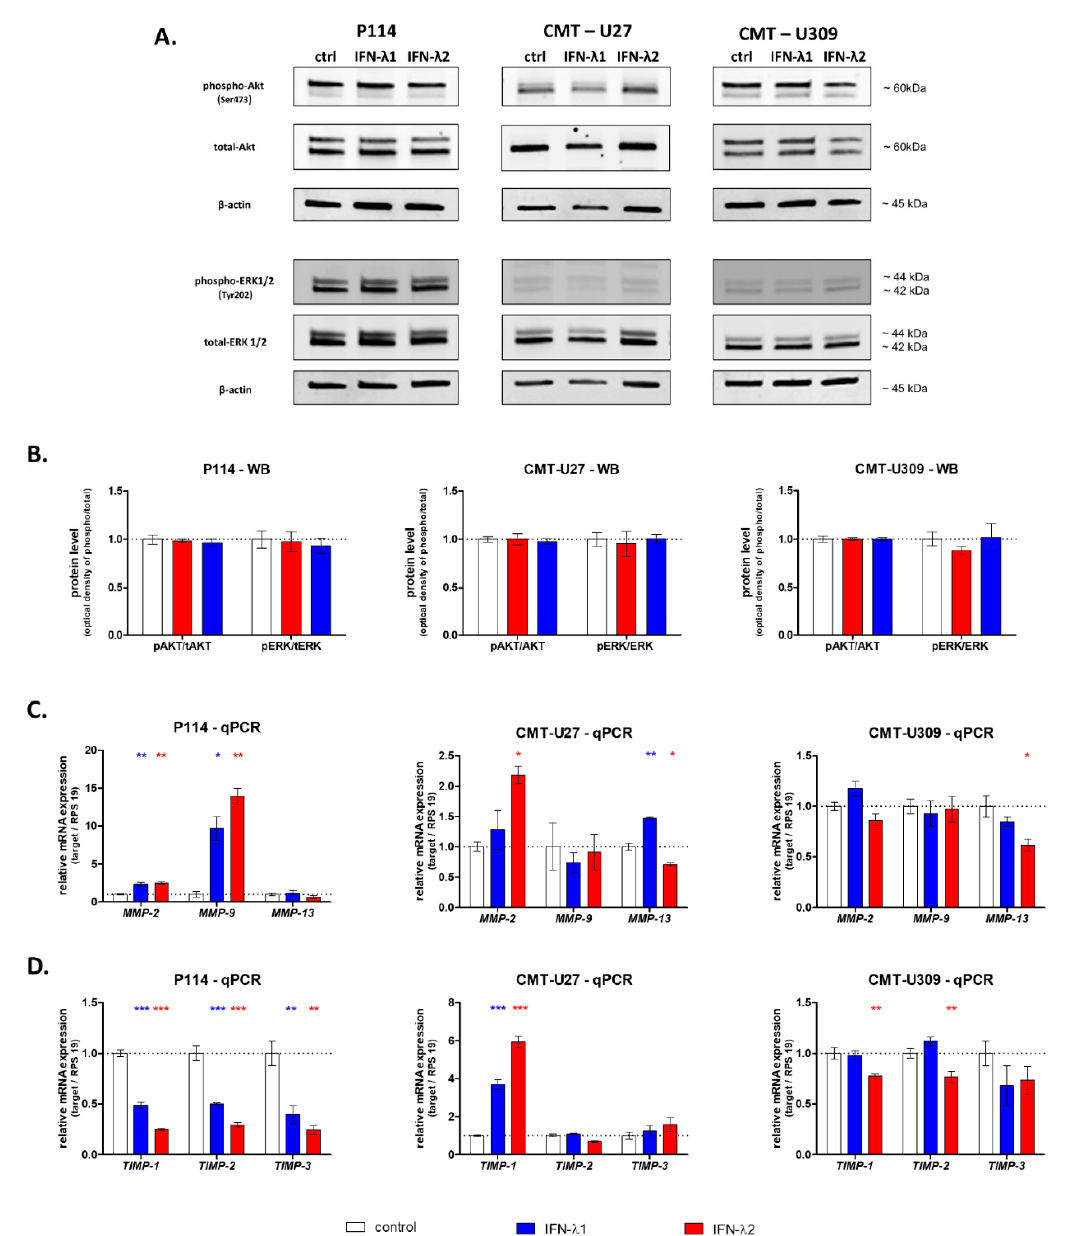
Figure 4. Representative images of Western blot showing the expression of phospho-Akt and Akt, phospho-ERK1/2 and total ERK1/2 and β -actin (loading control) in whole CMT cell lysates ( A ). The graphs showing the relative phosphorylation of Akt and ERK1/2 in CMT cells ( B ). The graphs showing the relative mRNA of extracellular matrix metalloproteinase expression in CMT cells treated with IFN- λ 1 and IFN- λ 2 for 24 h ( C ). The graphs showing the relative mRNA of extracellular matrix metalloproteinases inhibitor expression in CMT cells treated with IFN- λ 1 and IFN- λ 2 for 24 h ( D ). The results are presented as the mean ± SEM. A one-way ANOVA and Dunnet’s HSD post hoc test were applied. Significance levels are indicated as follows: * p < 0.05; ** p < 0.01; *** p <